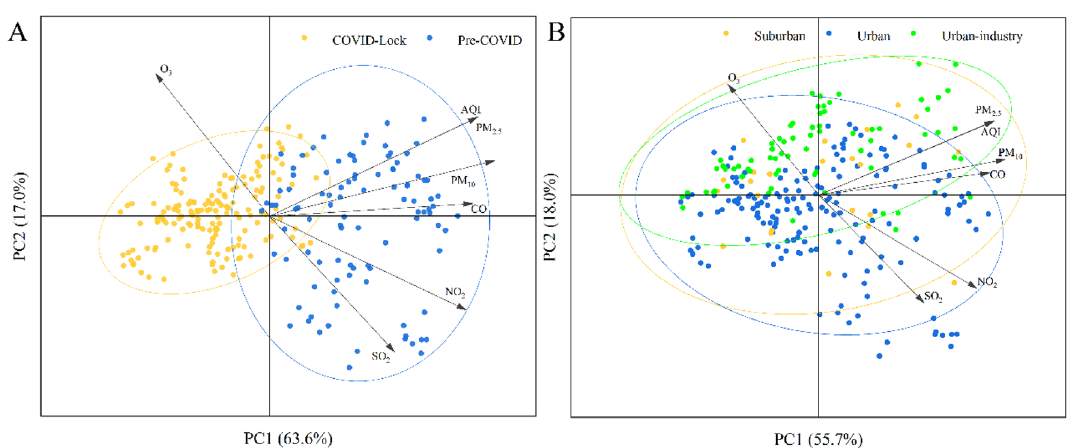
Figure 7. Principal component analysis (PCA) of air pollutants during the pre-COVID and COVID lockdown periods ( A ) and in urban, suburban and urban-industrial areas ( B